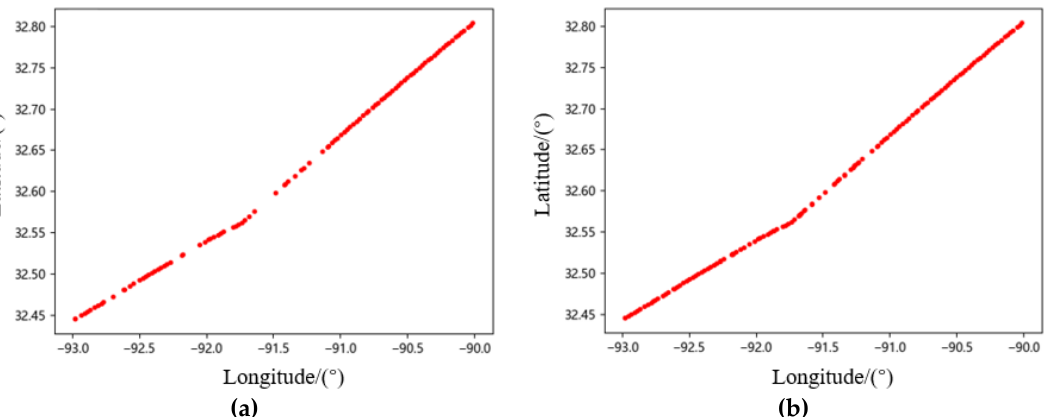
Figure 3. Linear interpolation: ( a ) trajectory before interpolation; ( b ) trajectory after interpolation. Algorithm 1: Trajectory Cleaning and Reconstruction